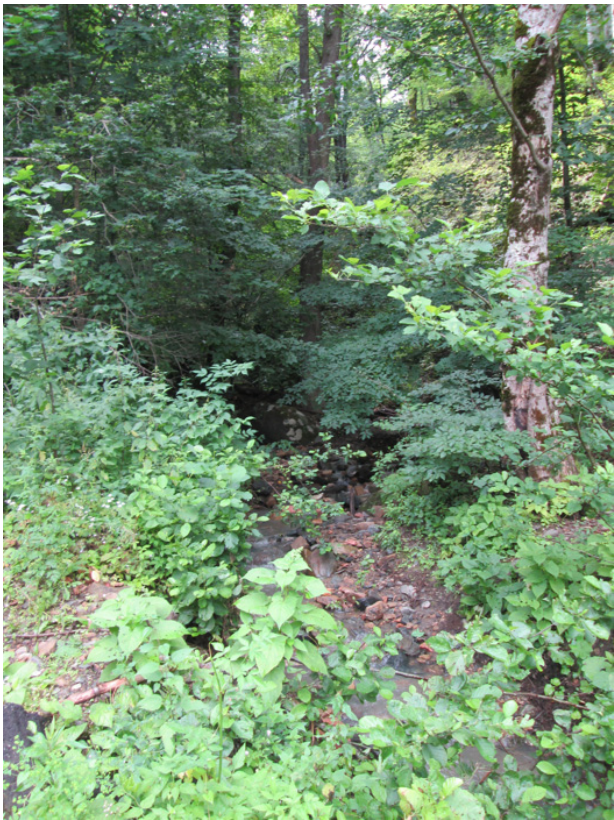
Figure 5. The “entrance” to the valley of the Lipovy River from the road; the dense vegetation and tree cover should be noted.